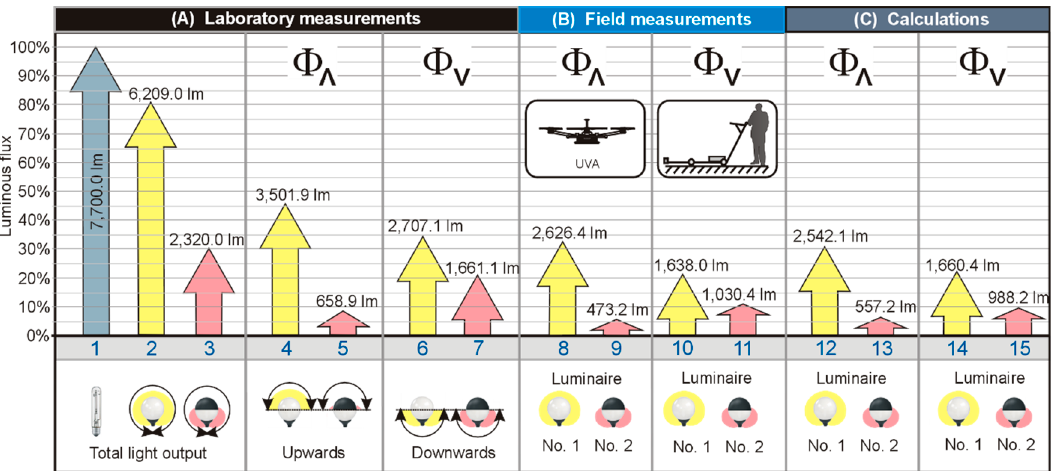
Figure 11. Graphical visualization of the luminous flux measured and calculated.